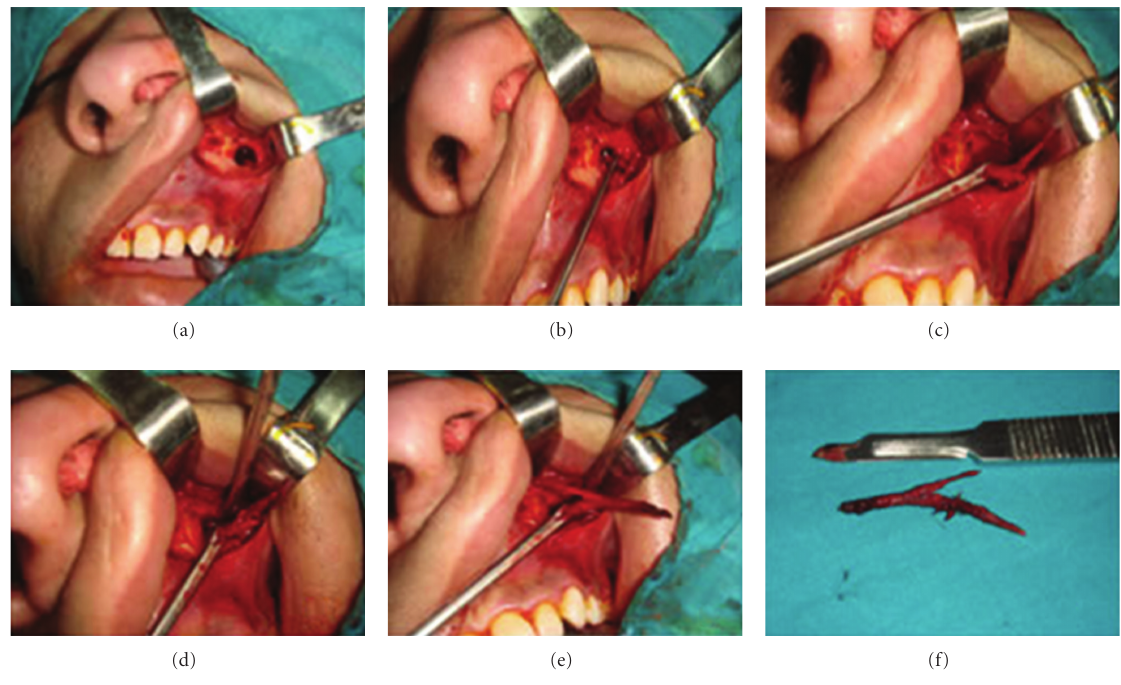
Figure 2: Removal of the wooden